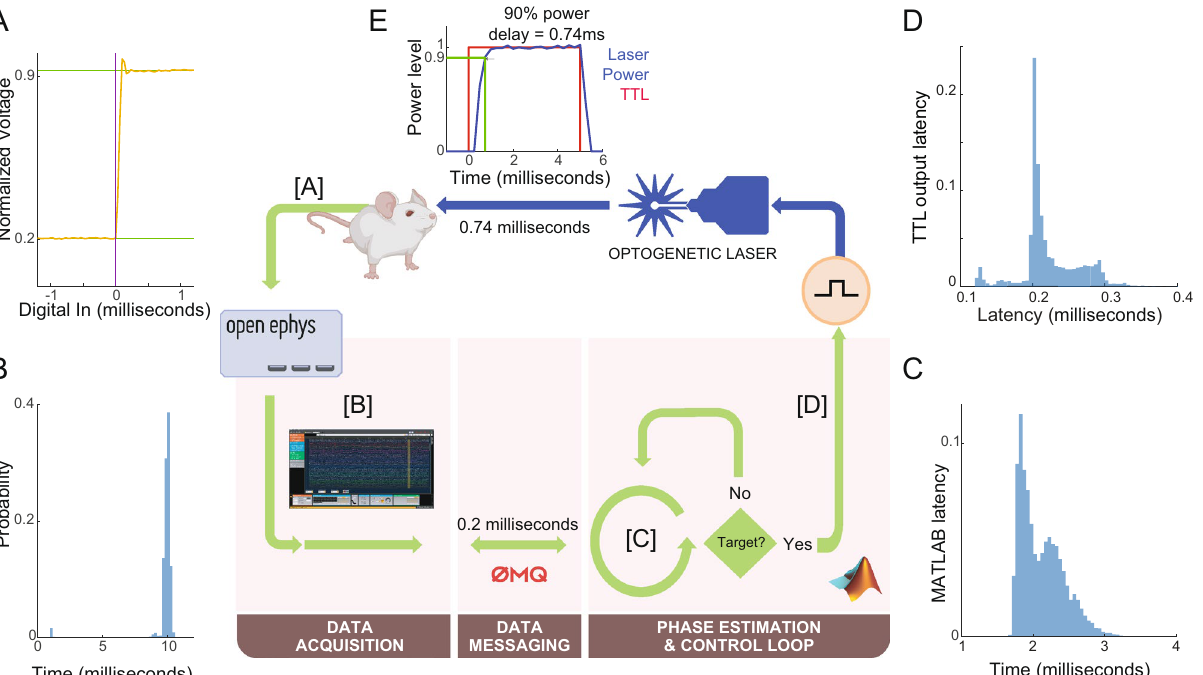
Figure 1. Phase-Adaptive Brain STimulation (PABST). ( A ) Brain recordings from an implanted mouse sampled at 24,000 samples/second are acquired via Open Ephys, and ( B ) buffered with a delay of ~ 10 ms. ( C ) The data is then transferred to a computer running MATLAB for phase estimation and closed-loop control with ~ 2.5 ms latency. After phase estimation and stimulation decisions are made, ( D ) a TTL is sent to an optogenetic laser, which ( E ) powers up over 0.74 ms, delivering a 5-ms pulse of 473-nm